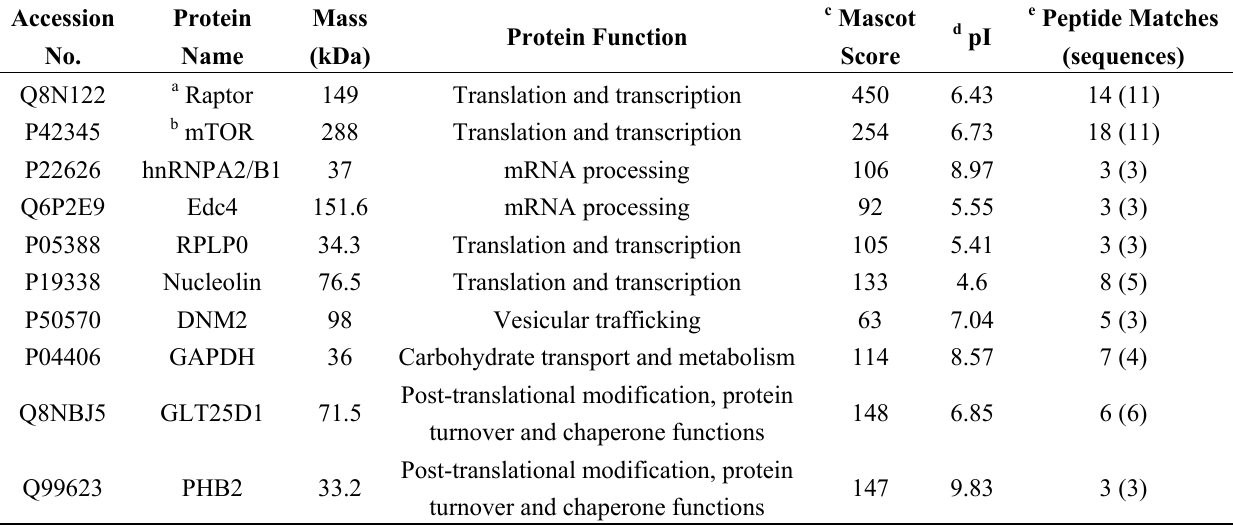
Table 1. Novel interacting partners of the raptor component of mTORC1 identified using nano-LC ESI Q-TOF MS/MS analysis.